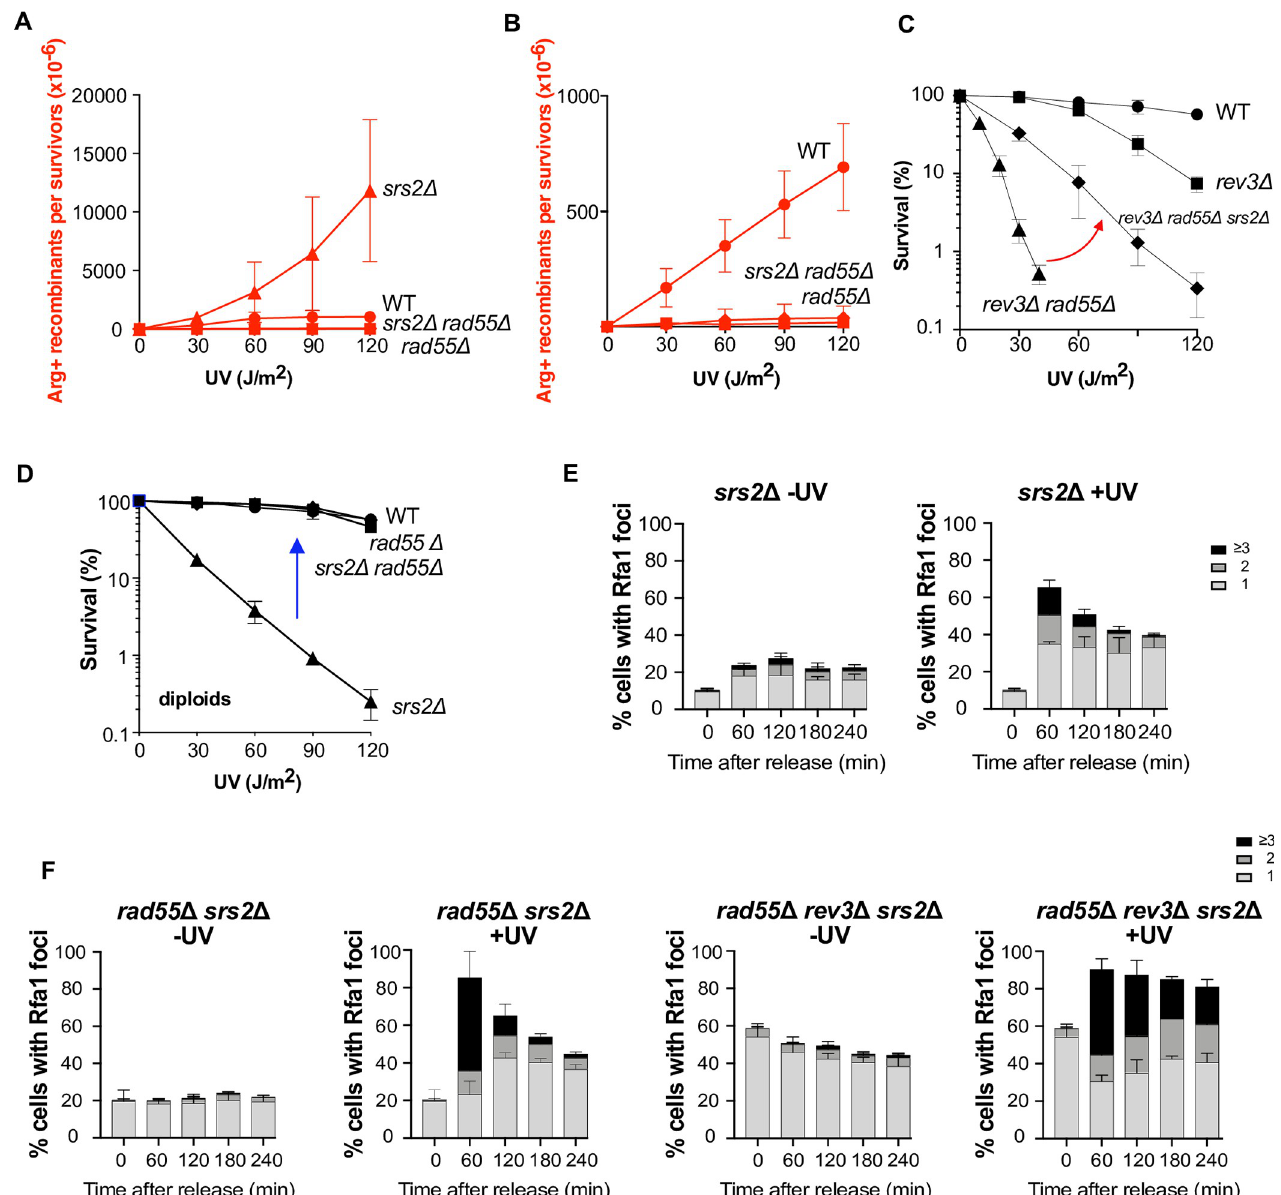
Fig 5. Srs2 role in the rad55 Δ mutant exposed to UV radiation. (A) UV-induced [Arg+] recombinant frequencies in rad55 Δ srs2 Δ diploid cells. (B) Close-up view of (A) to exclude the hyper-recombinogenic phenotype of srs2 Δ . (C) The acute UV sensitivity displayed by the rad55 Δ rev3 Δ mutant is partially suppressed by SRS2 deletion. The red arrow between the rev3 Δ rad55 Δ and rev3 Δ rad55 Δ srs2 Δ survival curves highlights the partial srs2 Δ suppression. (D) Survival curves of diploid cells following UV radiation. The acute sensitivity to UV radiation of the diploid srs2 Δ strain is suppressed by rad55 Δ (blue arrow). (E) Quantification of Rfa1-YFP foci detected by fluorescence microscopy in srs2 Δ cells not irradiated or after UV exposure. (F) Quantification of Rfa1-YFP foci detected by fluorescence microscopy in rad55 Δ srs2 Δ and rad55 Δ rev3 Δ srs2 Δ cells not irradiated or after UV exposure. Error bars indicate SDs from three independent